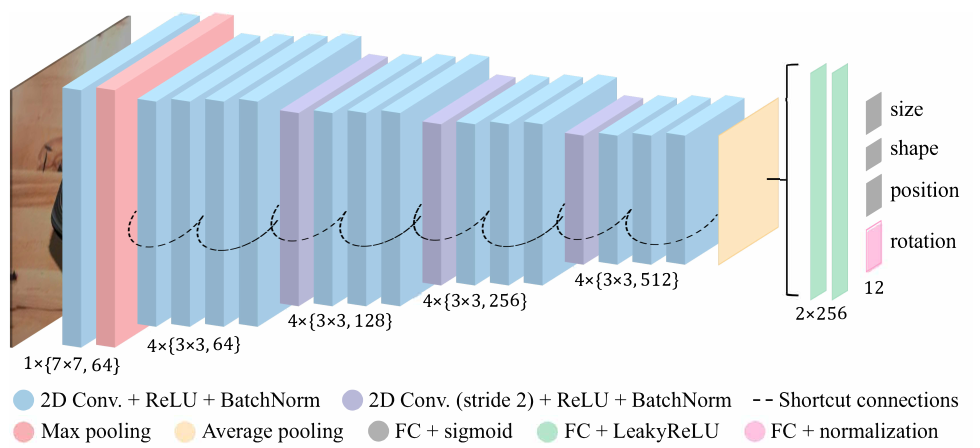
Figure 4. Visualization of the modified ResNet-18 model used for predicting superquadric parameters. The network input is a color image and the outputs are the different superquadric parameter